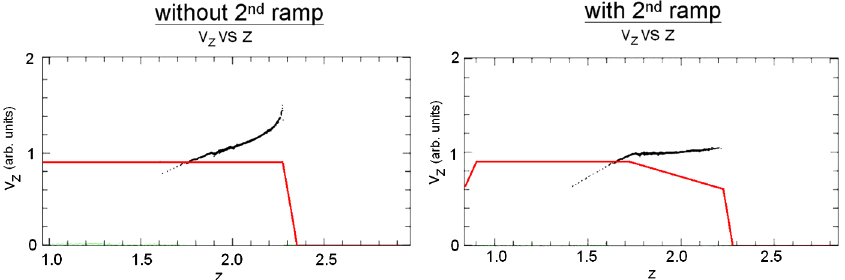
FIG. 6. (Color) The resultant phase space with and without the second ramp in the voltage waveform. Both helices start at z ¼ 0 : 7 m and end at z ¼ 1 : 9 m